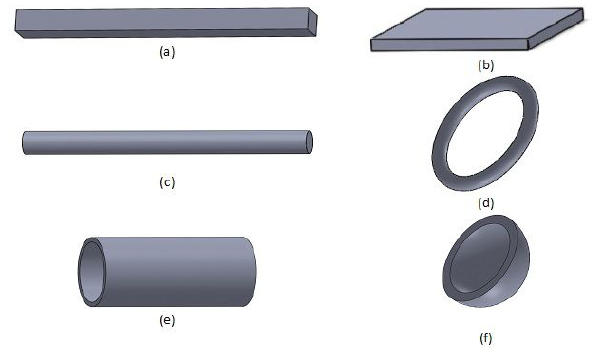
Figure 1: Different types of nanostructures: (a) nanobeam (b) nanoplate (c) nanobar (d) nanoring (e) single curved nanoshell (f) double curved